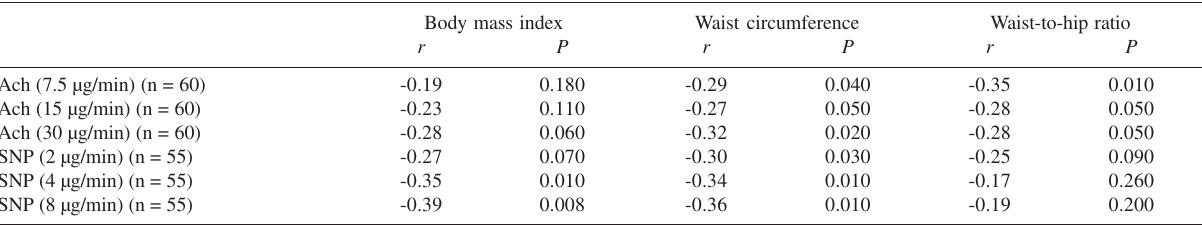
Table 3 - Correlations (Spearman r ) between forearm blood flow and obesity indexes in patients aged ≤ 40